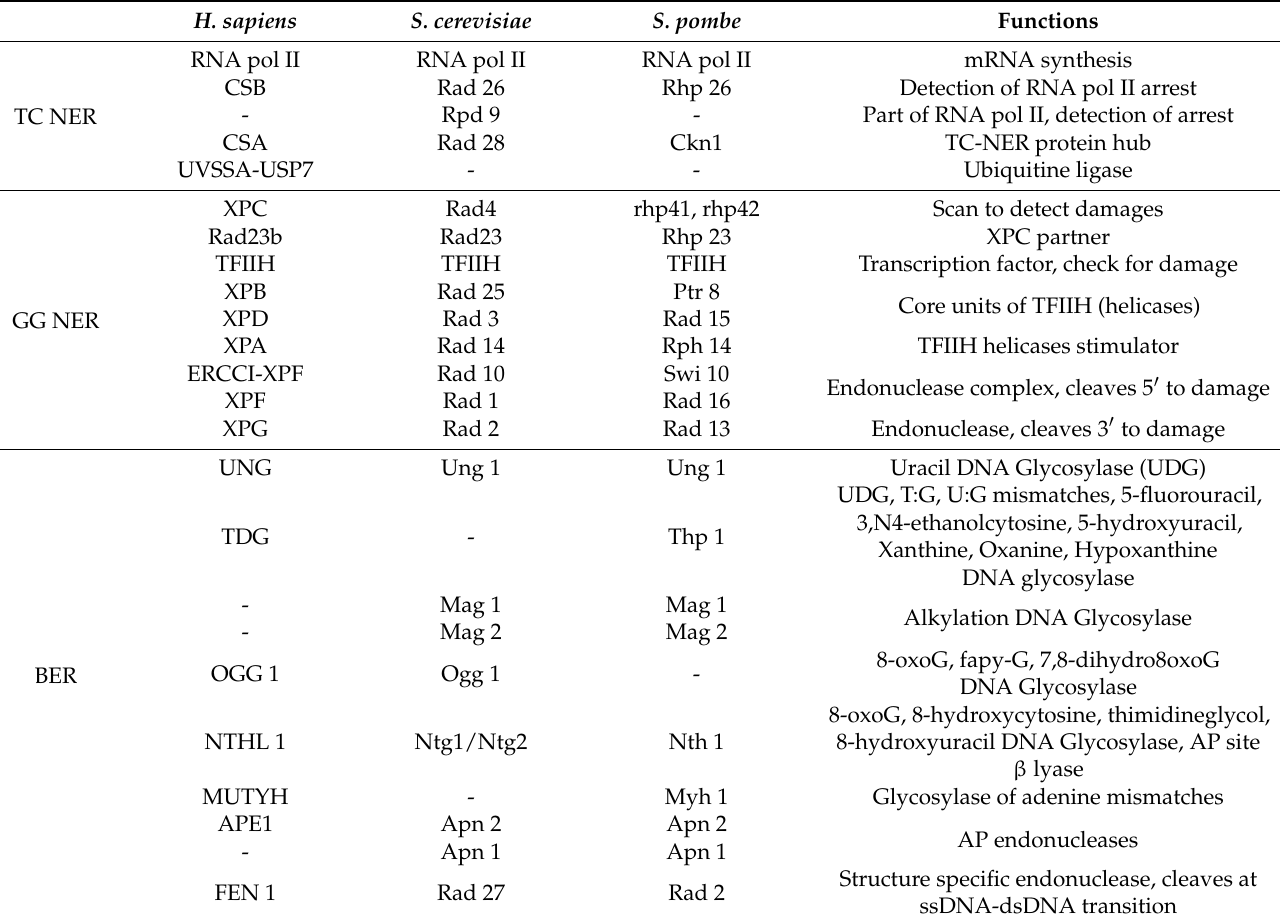
Table 1. Table of homologous